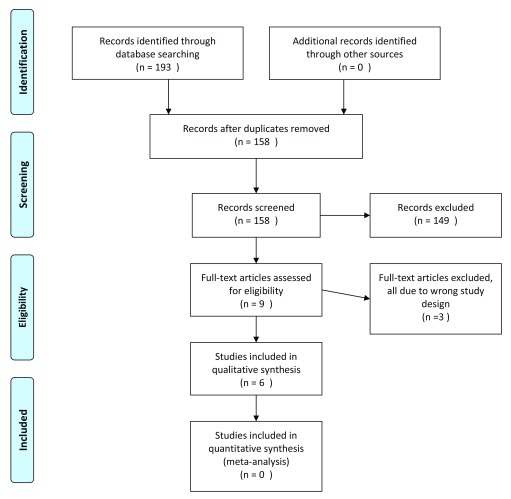
PRISMA flow diagram.